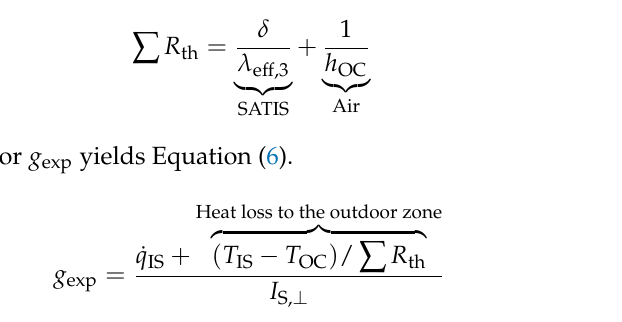
Table 2. Investigated angles of incidence ( ϕ ) and measured solar radiation intensities on a surface perpendicular to the direction of irradiation ( I S,